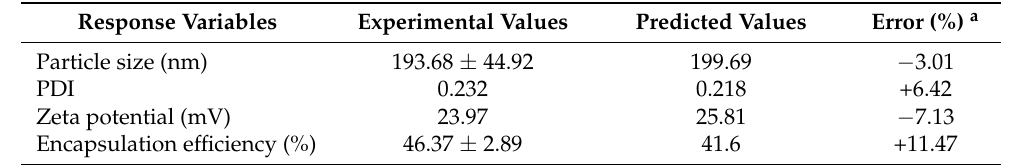
Figure 8. Particle size distribution of the optimized formulation. Table 4. Comparison of the experimental and predicted values of the response variables of the QCS nanoparticles prepared under the optimum conditions.